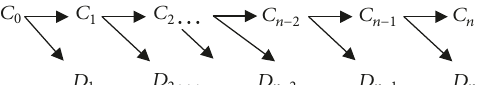
Obviously, the wavelet series information may be used to show the changes of the running state of the stacker